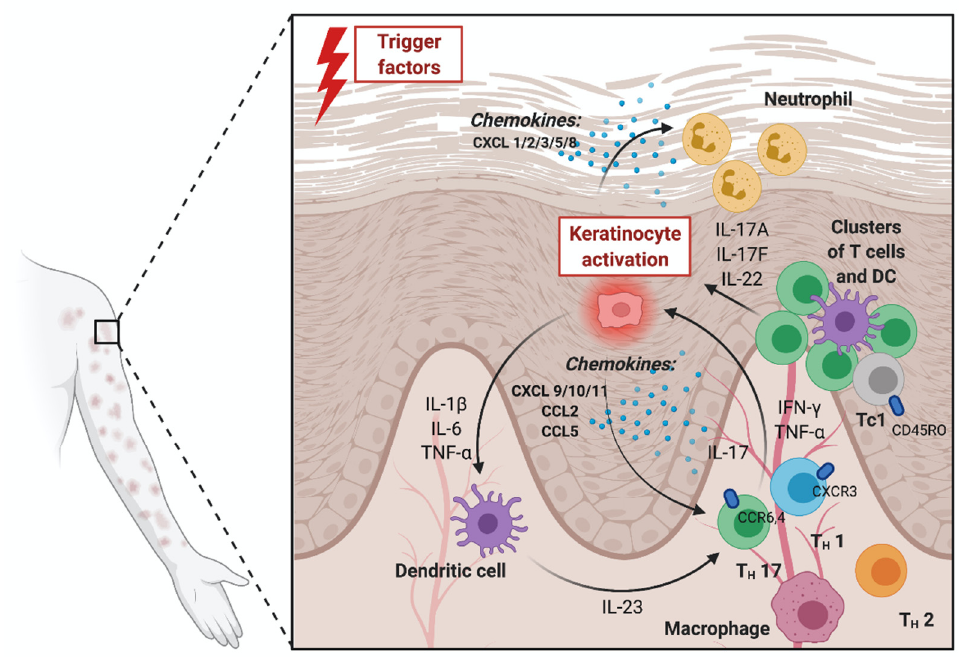
Figure 1. Presence of chemokines in the pathogenesis of psoriasis. Abbreviations: CCL—chemokine C-C motif ligand; CCR—chemokine C-C motif receptor; CXCL—C-X-C motif chemokine ligand; CXCR—C-X-C motif chemokine receptor; DC—dendritic cell; Th1—T helper 1 lymphocyte; Th17—T helper 17 lymphocyte; Th2—T helper 2 lymphocyte; IL—interleukin; IFN- γ —interferon gamma; TNF- α —tumor necrosis factor alpha. Own design based on [3,4]; figure created with BioRender.com.